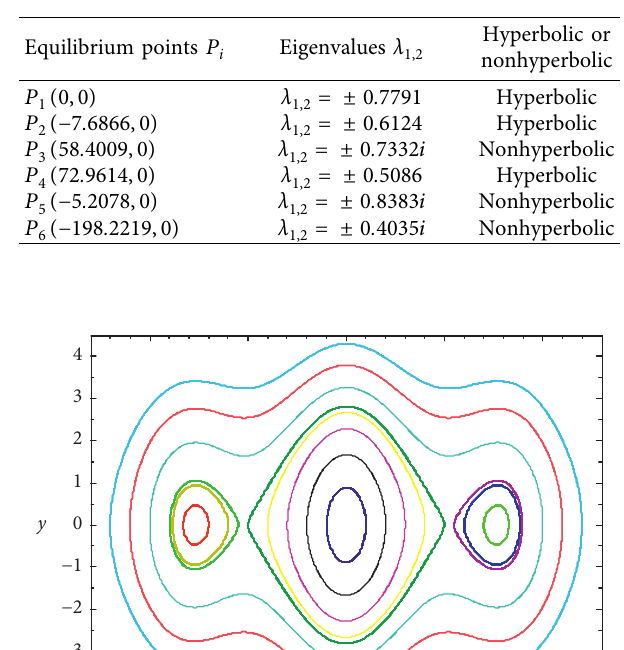
Table 3: Six examples of equilibrium points P and their corre-